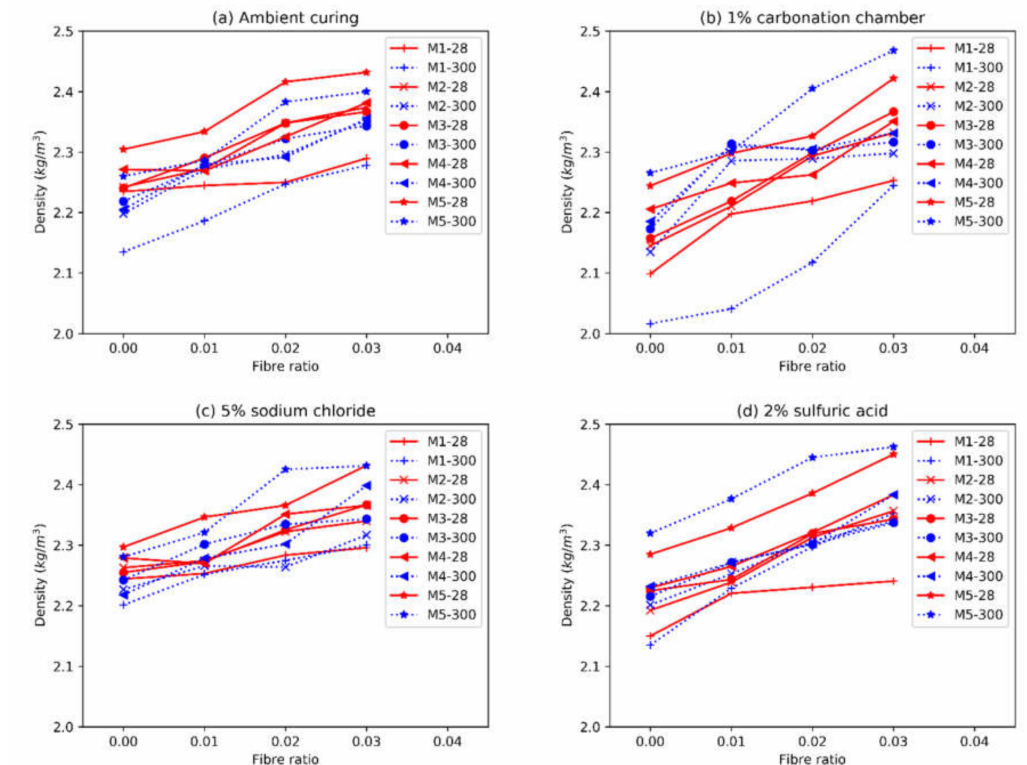
Figure 4. The apparent densities of the specimens at 28 and 300 days in ( a ) the ambient curing room, ( b ) the carbonation chamber, ( c ) open-air sodium chloride baths, and ( d ) sulfuric acid